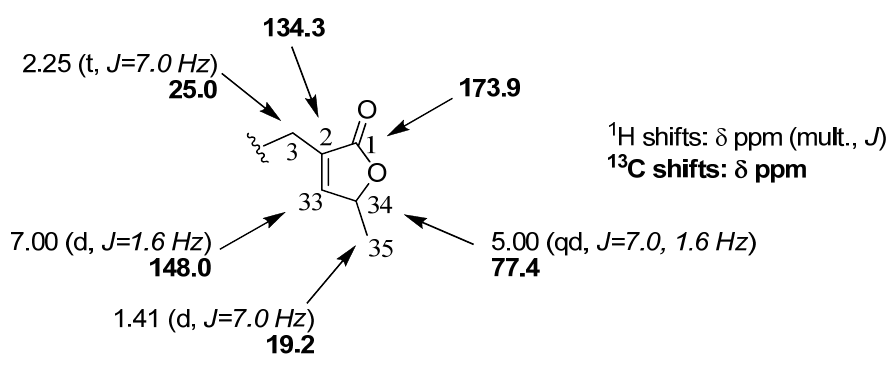
Figure 1. NMR shifts for the lactonic moiety of 1 + 2